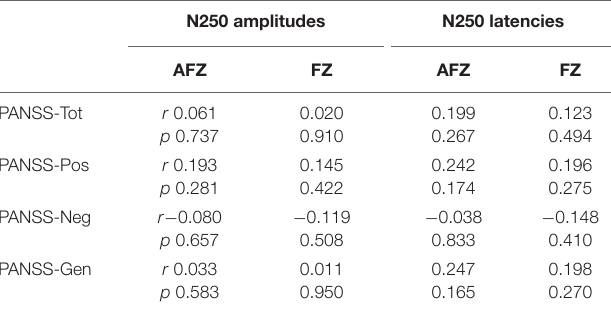
TABLE 2 | Correlations between N250 and